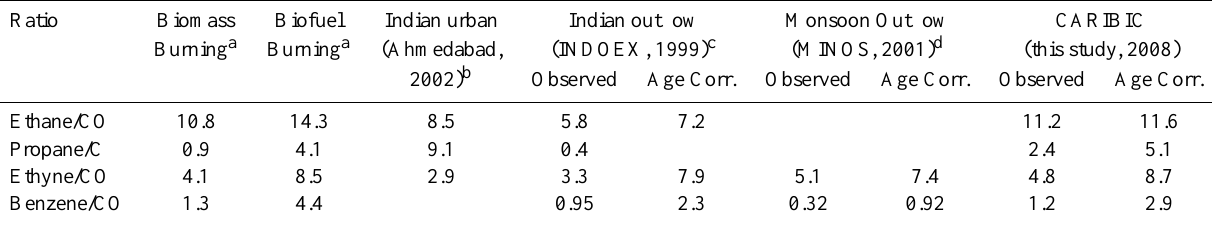
Table 3. Observed and age corrected ratios between select NMHC and CO for the current study (CARIBIC), compared to literature values. Observed refers to ratios determined from the measurements, Age corr. refers to values corrected for photochemical loss during transport (see text). Units are pptvppbv − 1